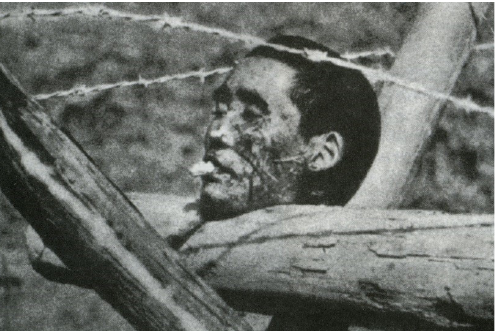
Figure 6. Severed Chinese head. Source: AP